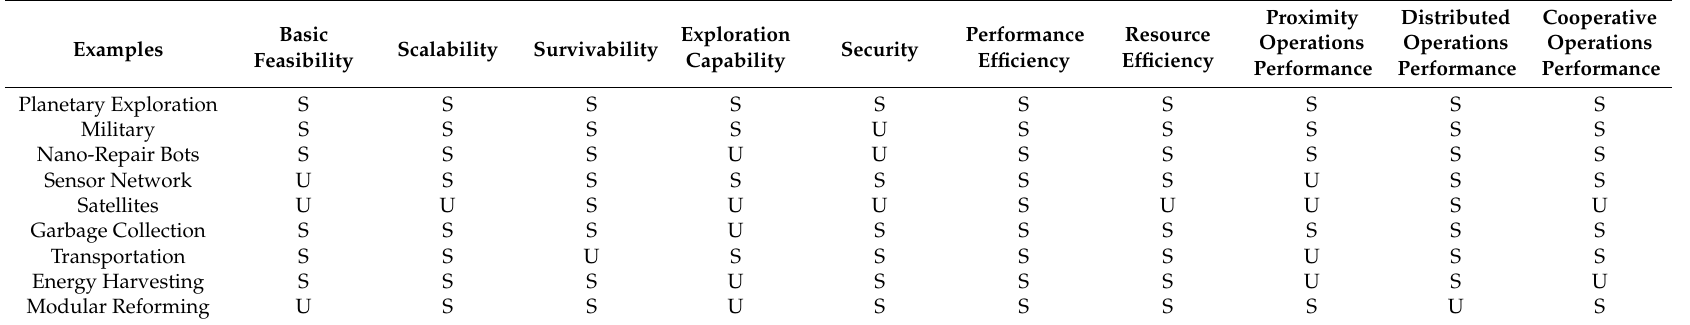
Table 1. Examples (described above) evaluated by performance characteristics. ‘S’ indicates that the proposed approach is satisfactory for the example, while ‘U’ indicates that it is